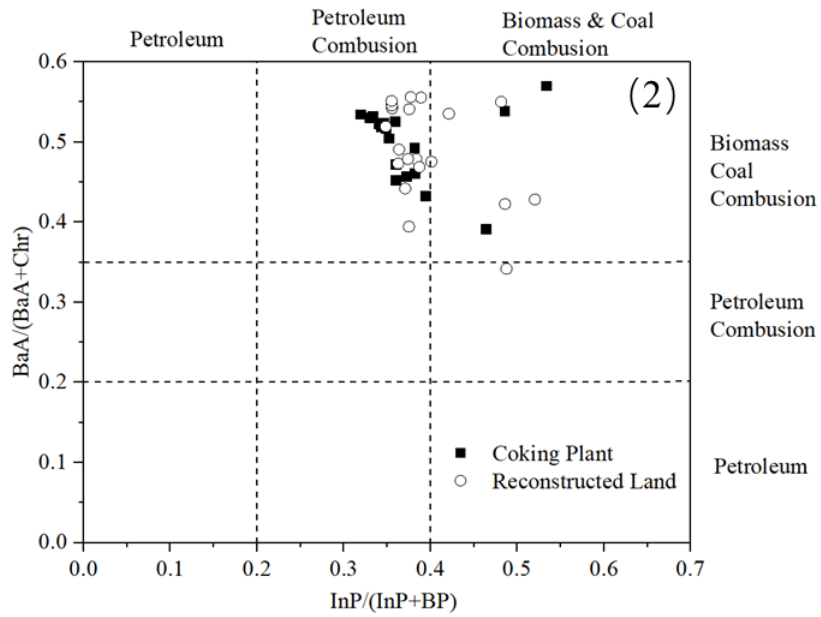
Figure 4. Cross-plots for the individual PAH ratios in the reconstructed land and previous coking plant: ( 1 ) Ant/(Ant + Phe) versus Flu/(Flu + Pyr) and ( 2 ) BaA/(BaA + Chr) versus InP/(Inp + BP).